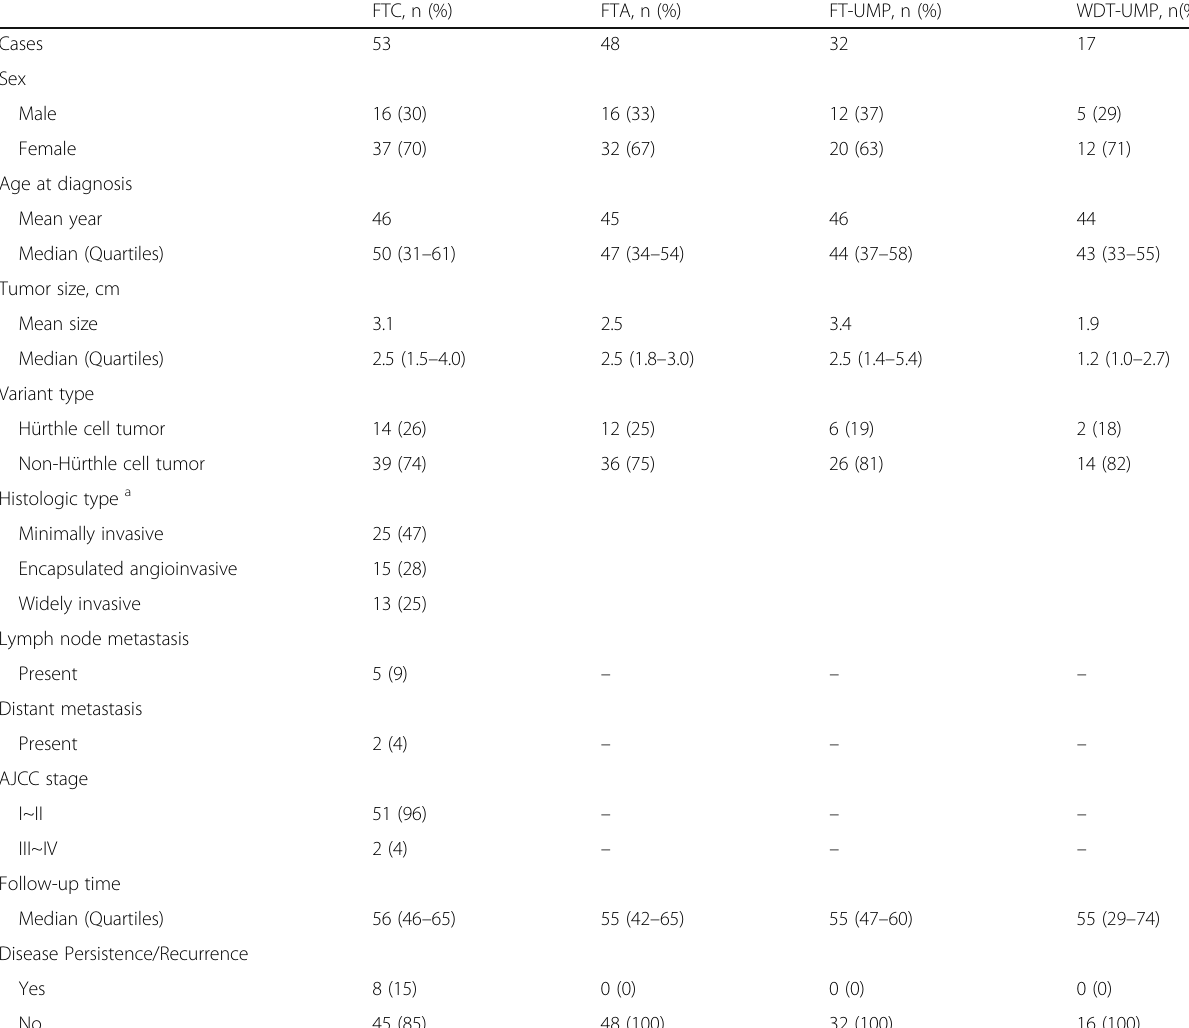
Table 1 Clinicopathological features of 150 patients with follicular thyroid tumors FTC, n